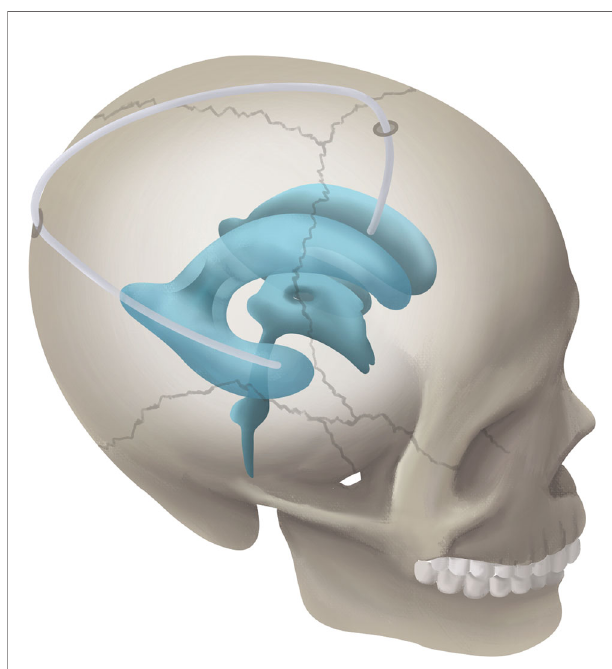
FIGURE 1 | Schematic diagram showing the RTFHS technique, shunting CSF from temporal horn to frontal